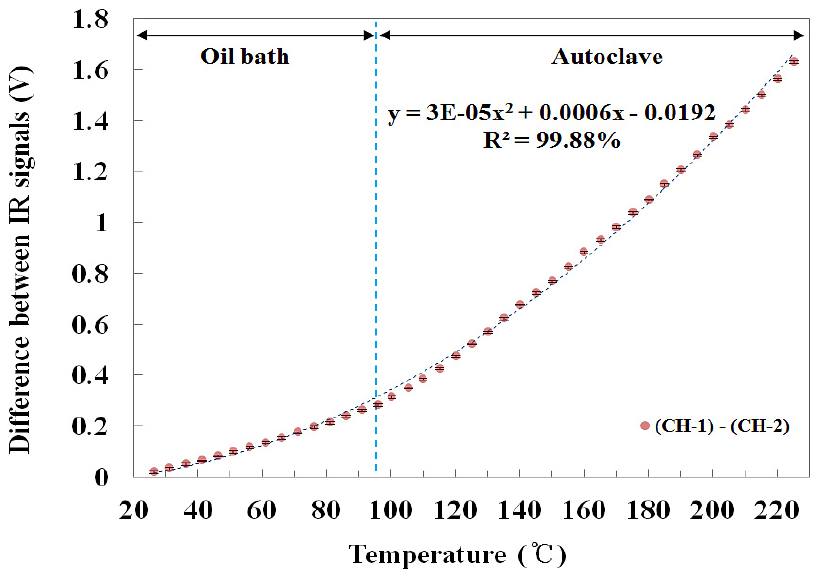
Figure 8. Relationship between the temperature of the water and the difference in IR signals between CH-1 and